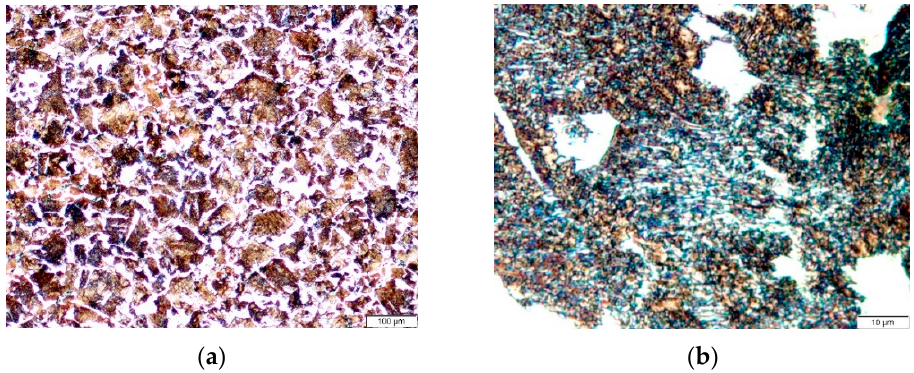
Figure 3. Optical micrograph for AISI 4340 high-strength steel: ( a ) overview microstructure and ( b ) alternate lamellas of ferrite and iron carbide within a pearlite grain.